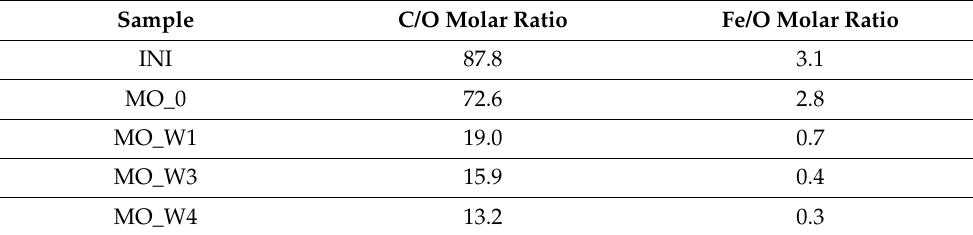
Table 4. Fe/O and C/O molar ratio according to EDX analysis.